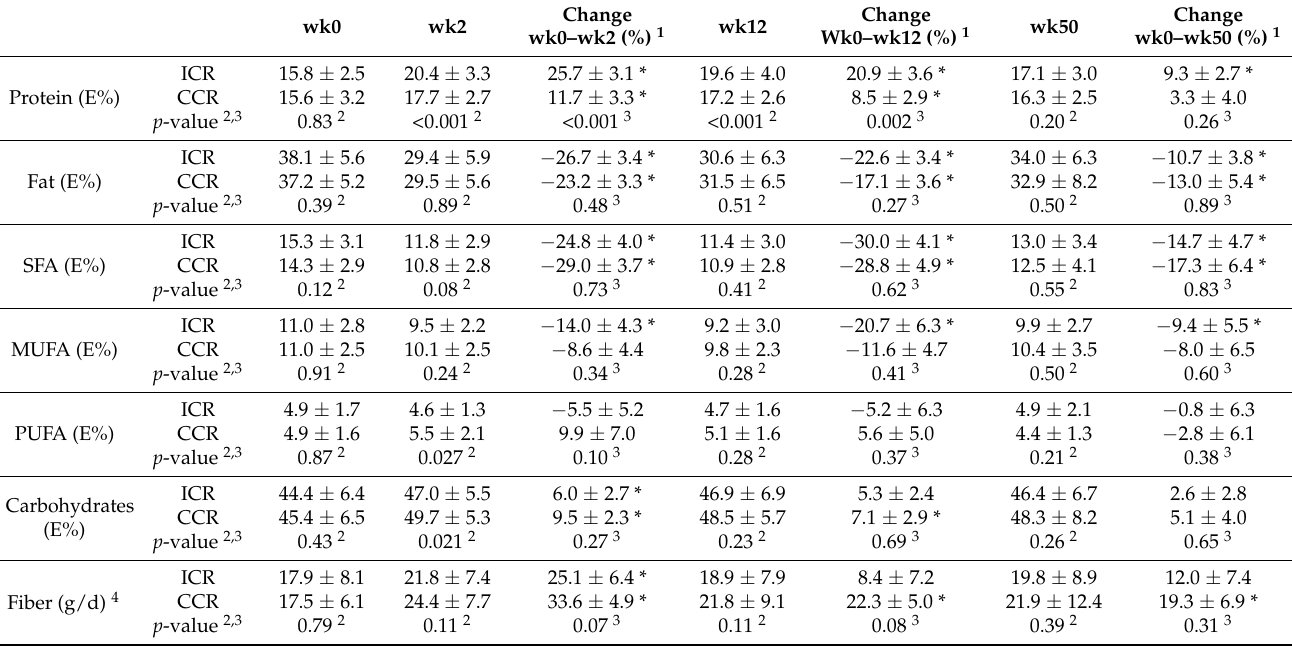
Table 3. Changes in relative macronutrient intake by intervention group 1 .